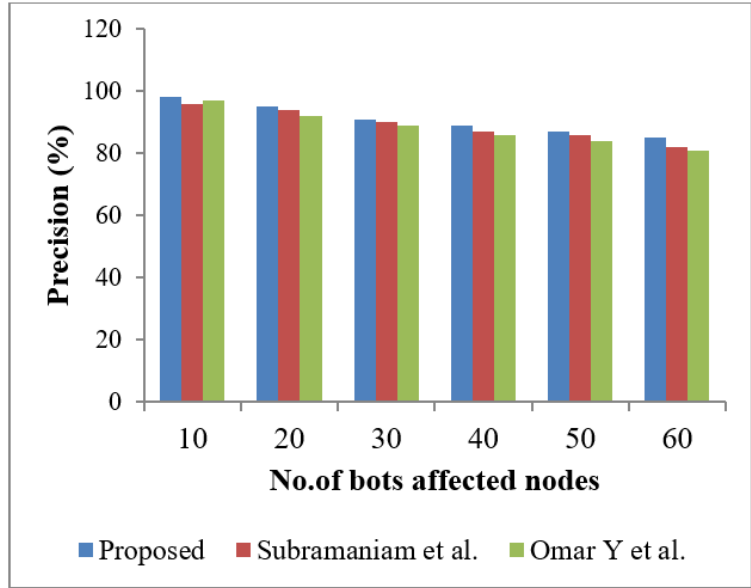
Figure 9. Comparisons of Precision.